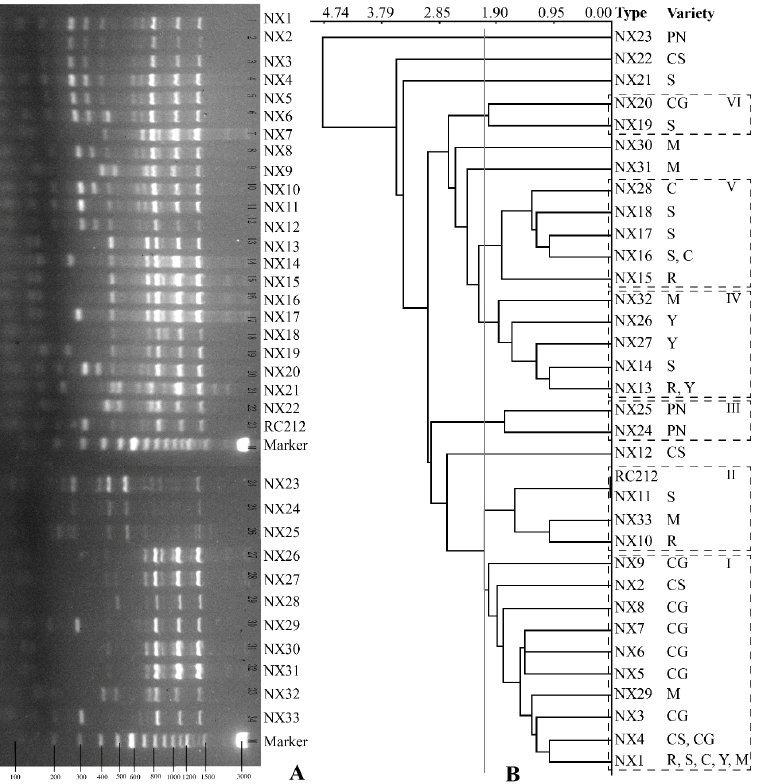
Figure 3. Interdelta fingerprinting of the indigenous S. cerevisiae clustering of isolates from Ningxia region. ( A ): Interdelta sequence profiles of the 33 distinctive genotypes. ( B ): UPGMA dendrogram generated from Interdelta fingerprinting patterns of 33 genotypes. C, Cinsault; CG, Cabernet Gernischet; CS, Cabernet Sauvignon; M, Merlot; PN, Pinot Noir; R, Riesling; S, Semillon; and Y, Yan73.